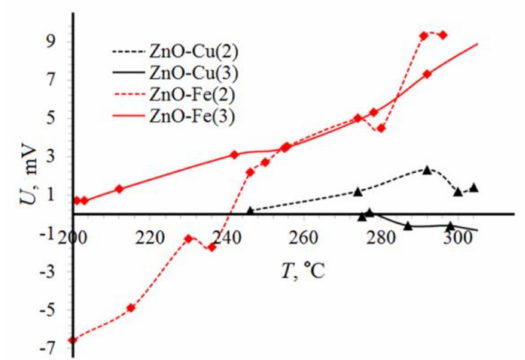
Figure 2. Temperature dependence of electromotive force in ZnO/ZnO–Me structures in the air